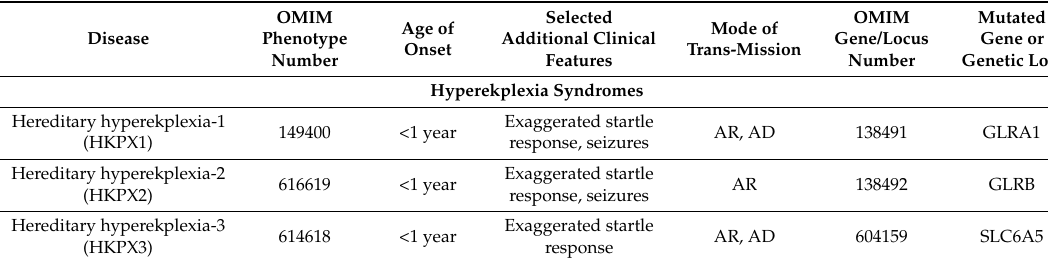
Table 2. Genetic dissection of myoclonic